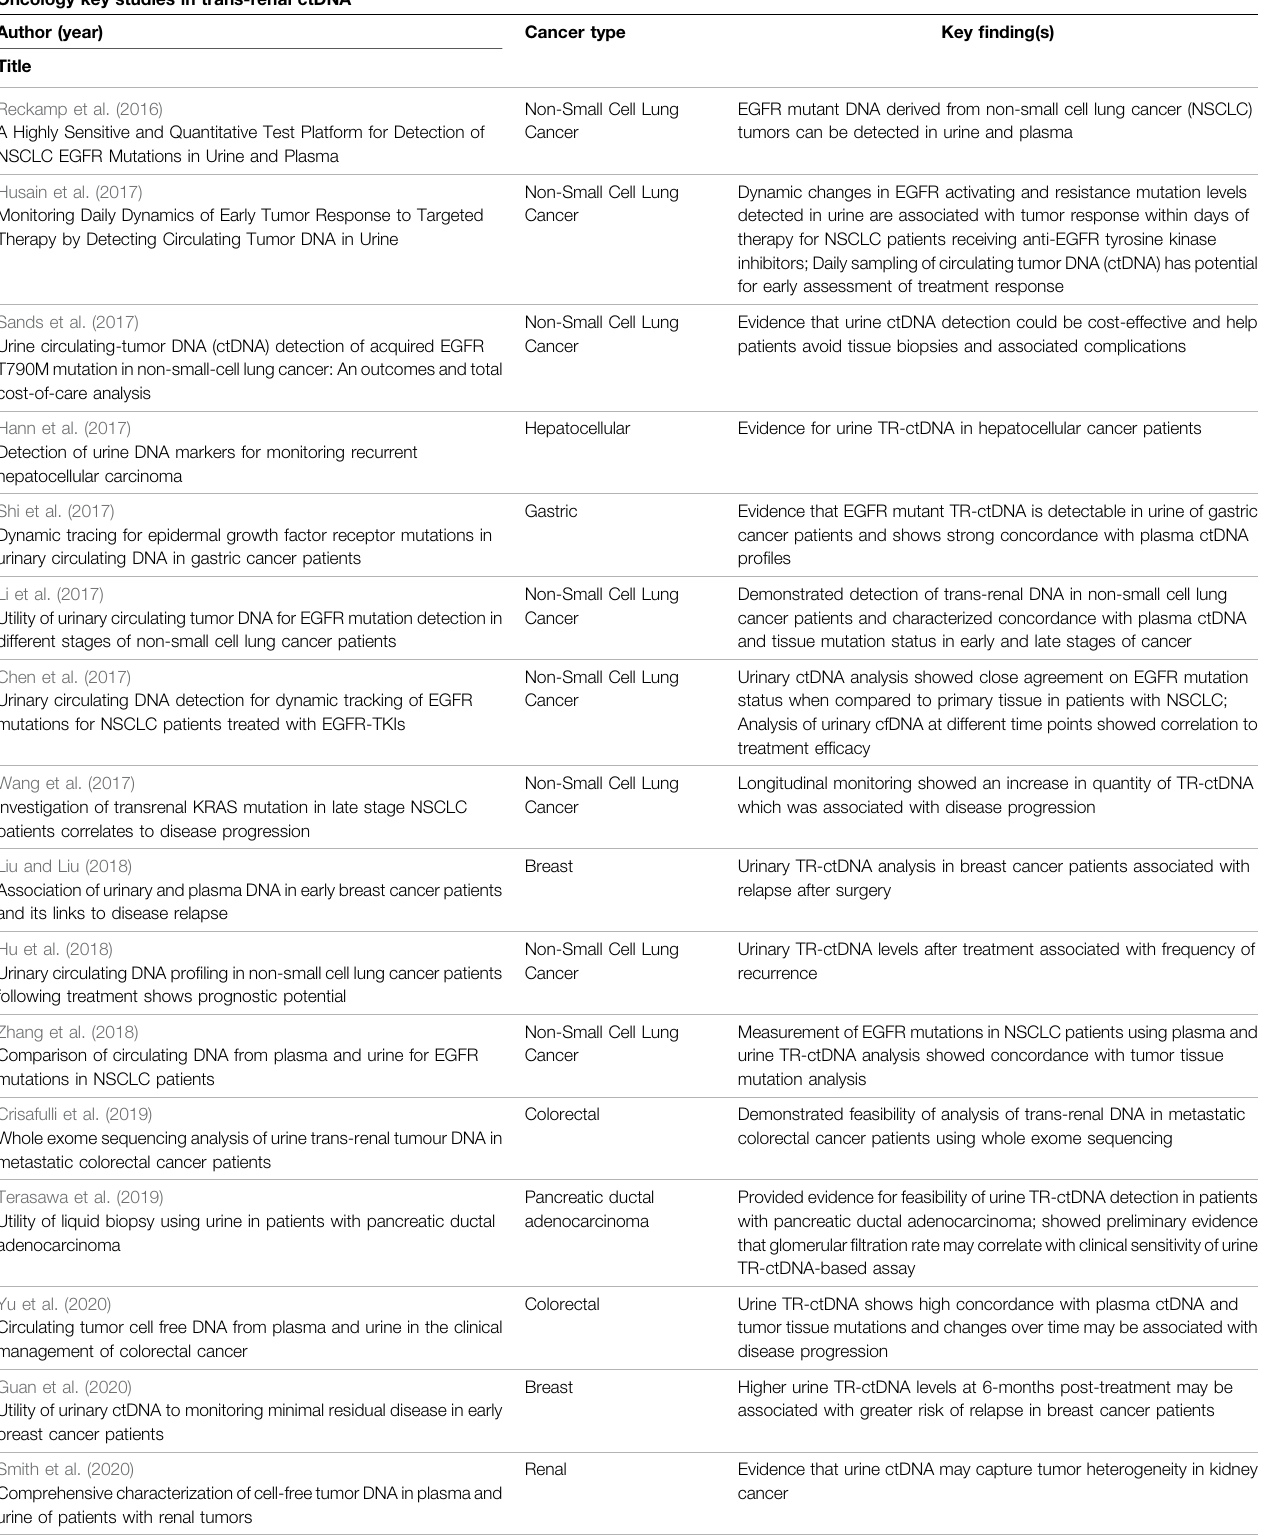
TABLE 1 | ( Continued ) Key Trans-Renal cell-free DNA Studies in Non-Oncology and Oncology